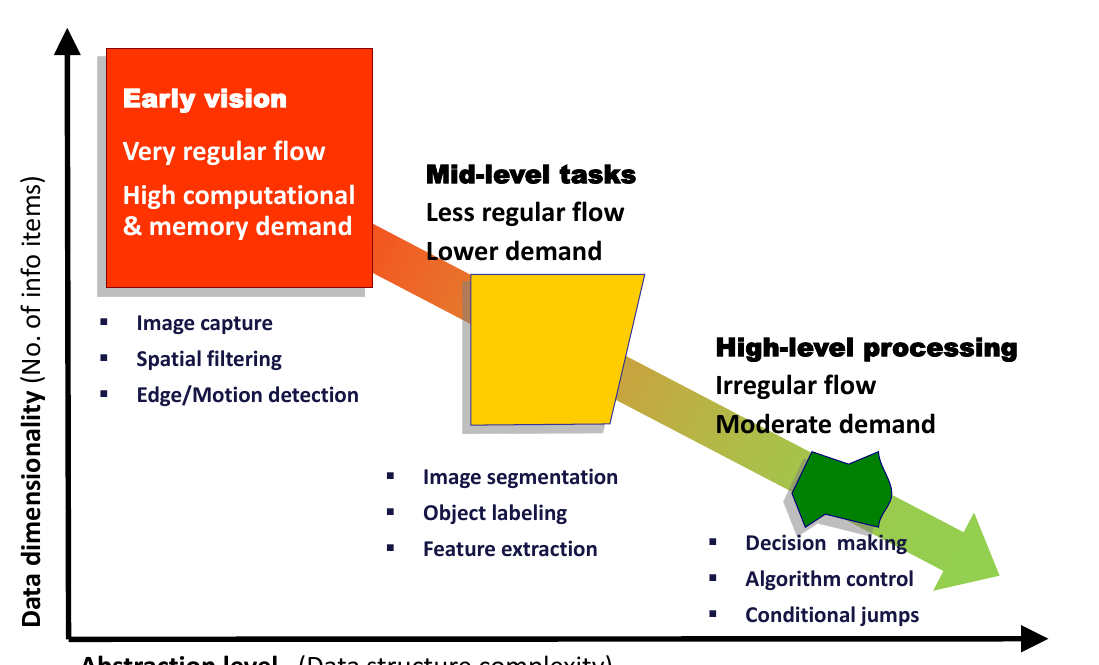
Figure 1. Comparison of data dimensionality vs. abstraction level for artificial vision. Early vision represents the critical stage in terms of computational and memory